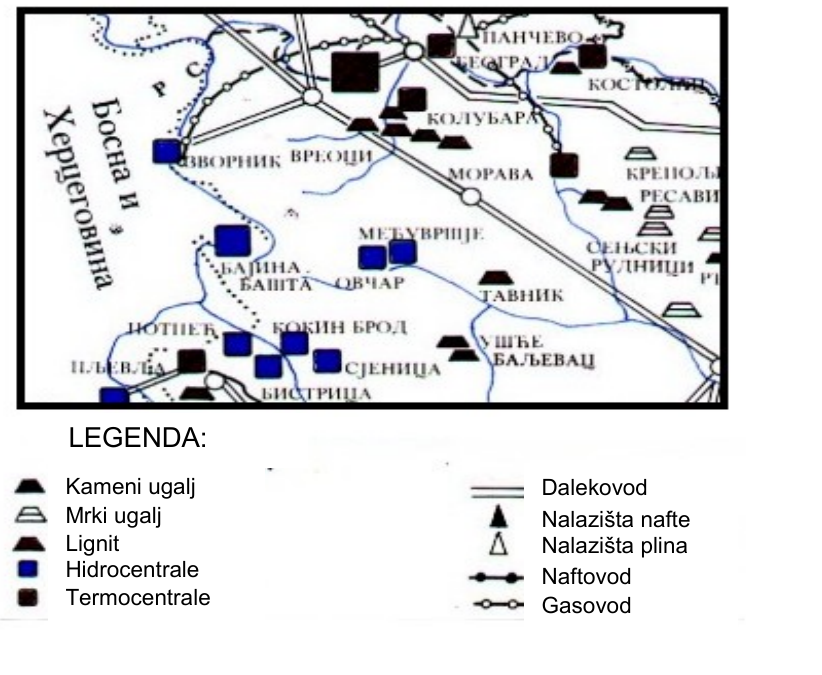
Figure 2 – Types of power generating